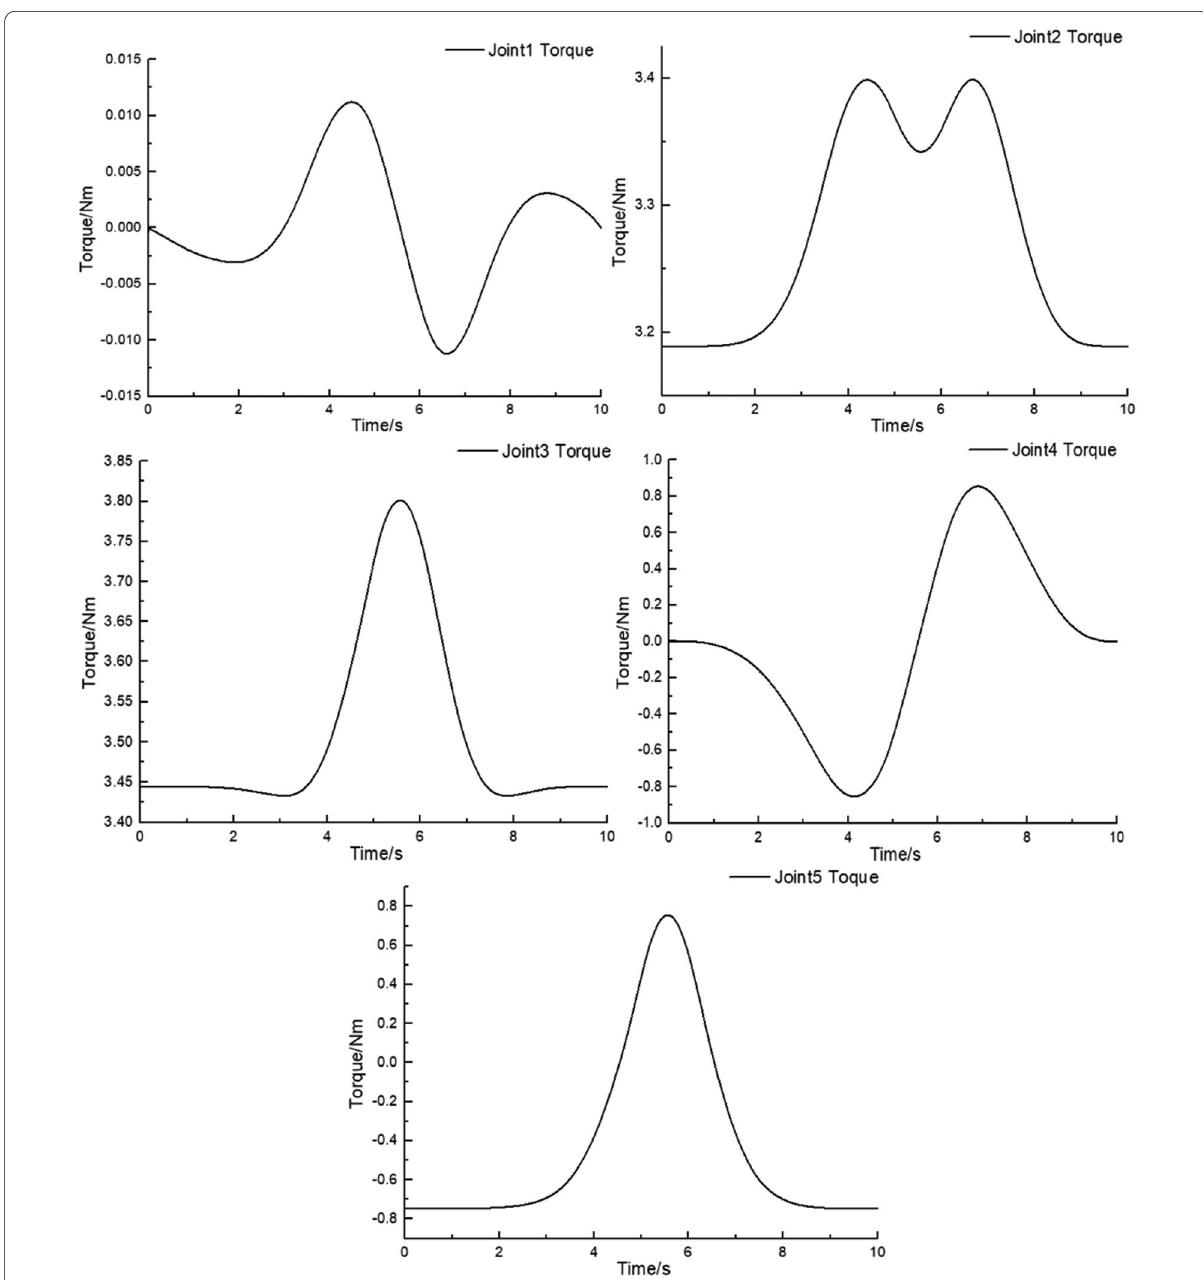
Figure 4 Driving torque of each joint in